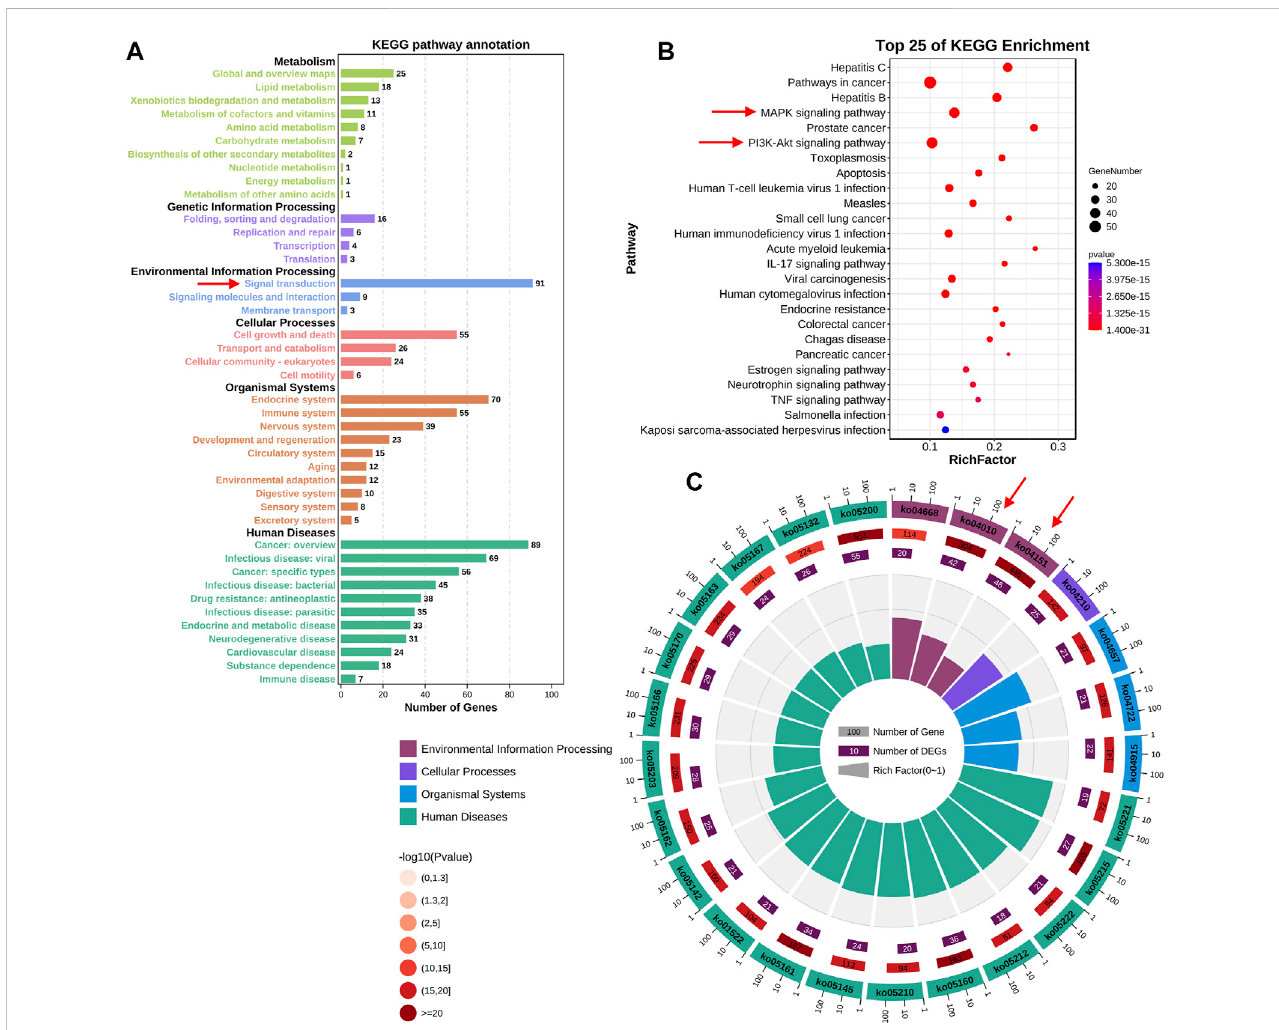
FIGURE 4 KEGGenrichmentanalysisofthekeytargetsofFMNTandCSagainstcoloncancer (A) ThenumberofgenesinvolvedintheKEGGenrichmentannotation (B) KEGGenrichmentanalysisofthe147keytargets.Thetop25enrichedKEGGpathwaysaredisplayed,andonlytermswith p < 0.05wereselectedforanalysis (C) The number of genes and rich factors of the top 25 enriched KEGG